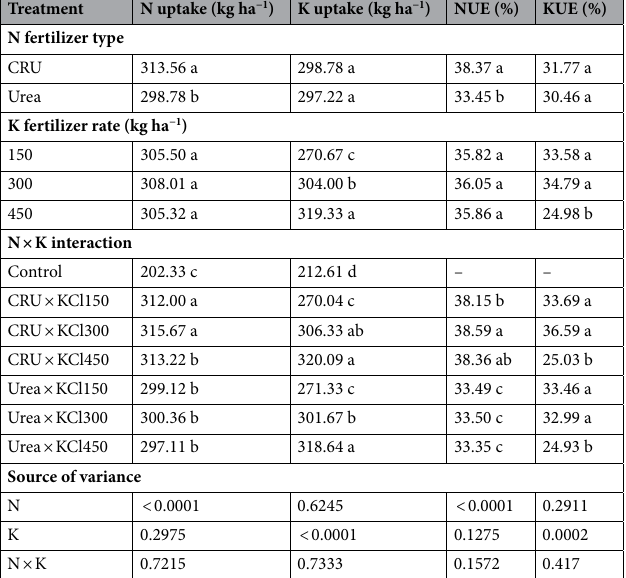
Table 7. The N uptake, K uptake, N use efficiency (NUE) and K use efficiency (KUE) of Italian ryegrass. Means followed by different lowercase letters in the same column were significantly different based on analyses with ANOVAs followed by Duncan tests ( P < 0.05). Control no N and K fertilizer, CRU controlled-release urea, KCl potassium chloride.